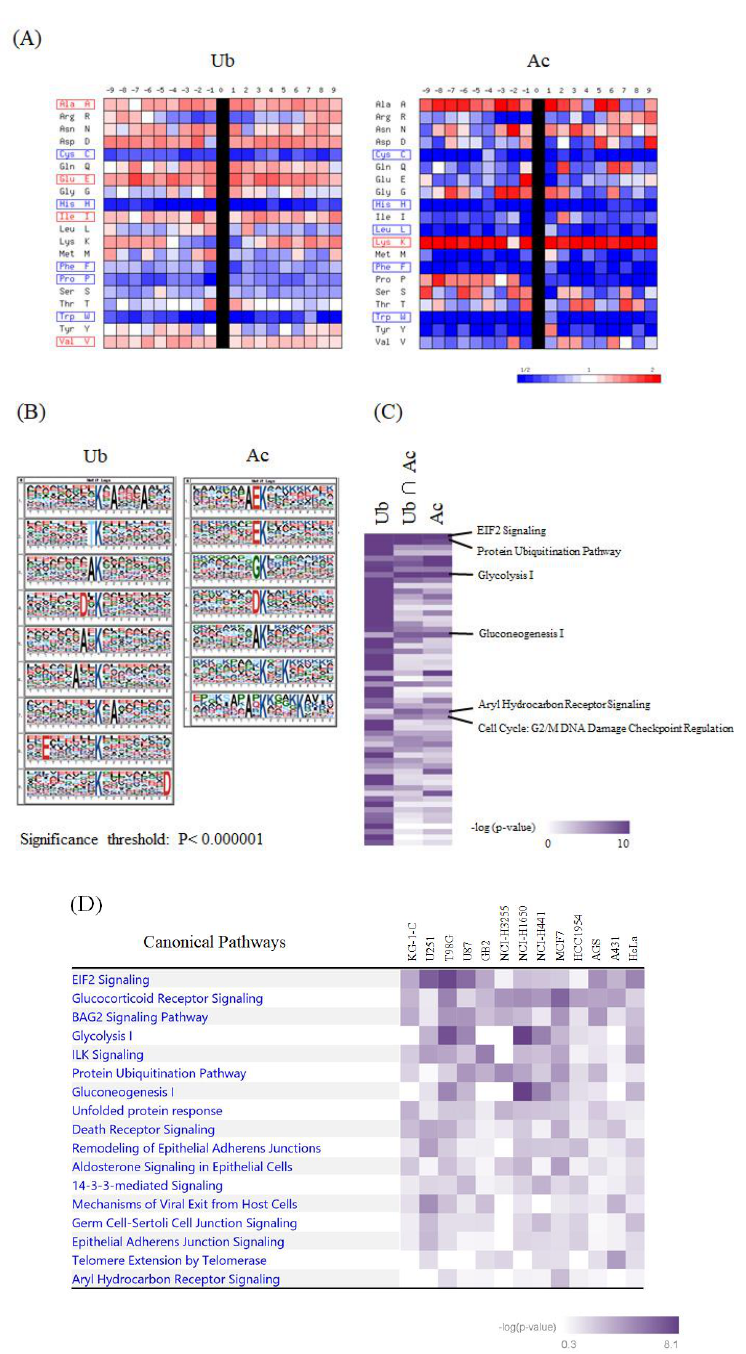
Figure 3. The integrative bioinformatic analysis of the large-scale protein ubiquitination and acetylation data. ( A ) The visualization of position weight matrices (PWMs) for the flanking amino acid residues of the ubiquitination and acetylation sites identified in our large-scale proteomic measurements. The probability of the observed amino acid residues at each flanking position was normalized by the abundance ratio of each amino acid in the NCBI RefSeq human protein database. ( B ) The visualization of statistically extracted sequence motifs based on our large-scale lysine modification proteome data. The sequence motifs surrounding the lysine modification residues were represented as sequence logos by the motif-x algorithm. ( C ) The heatmap for the canonical pathways defined by the Ingenuity Pathway Analysis (IPA). The representative canonical pathways are indicated at the right side of the clustered data. ( D ) The IPA-based canonical pathway analysis of the dually modified proteins identified from each cancer cell line.